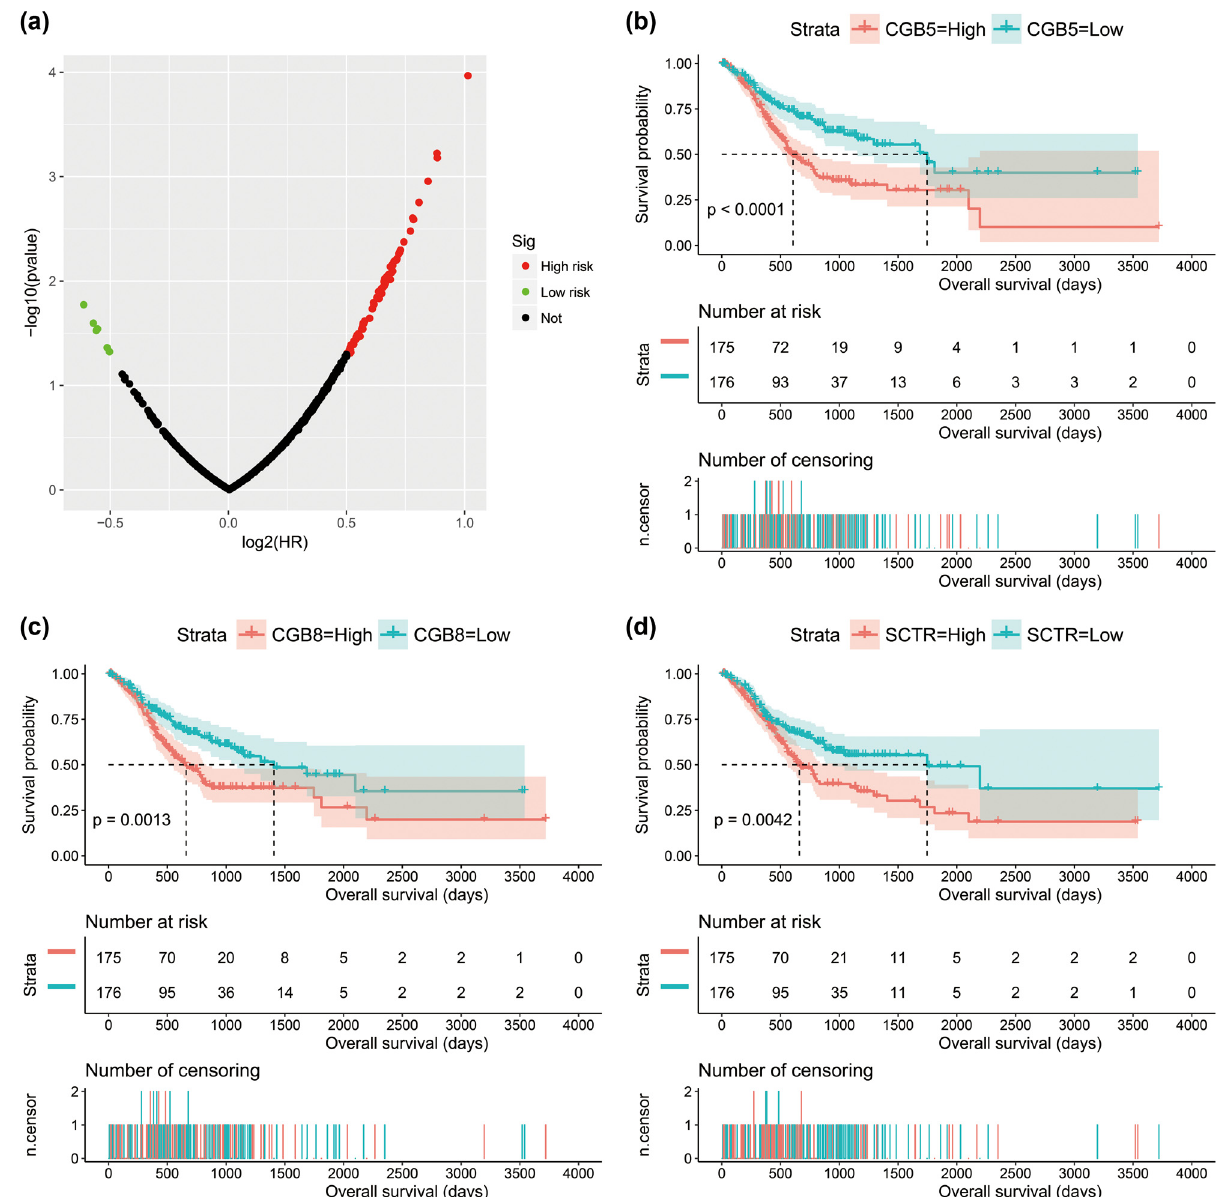
Figure 9: Survival analysis of DEGs between low - and high - risk score phenotypes in GC: ( a ) volcano plot of survival analysis results; ( b ) Kaplan – Meier curve of CGB5; ( c ) Kaplan – Meier curve of CBG8; and ( d ) Kaplan – Meier curve of